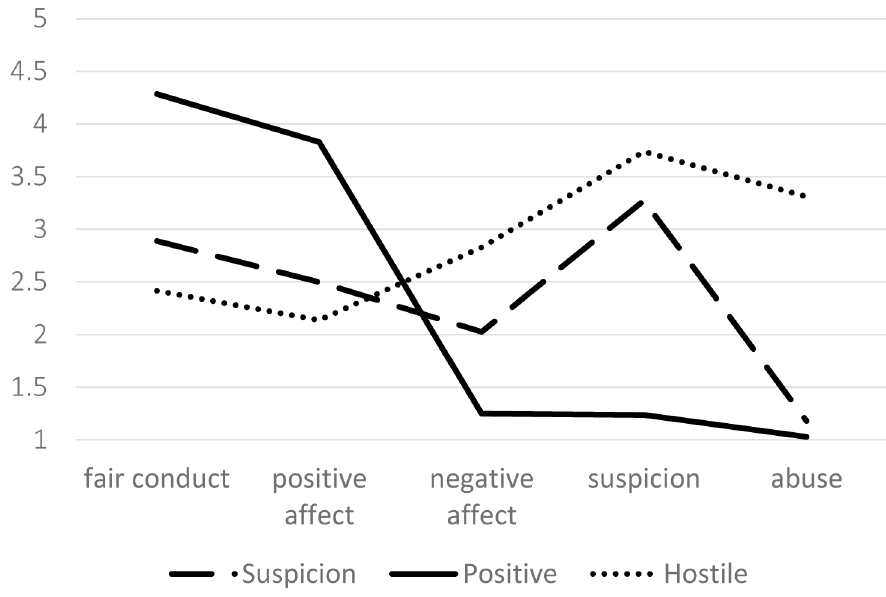
Fig 1. Estimated values for each of the dimensions of experience derived from three latent